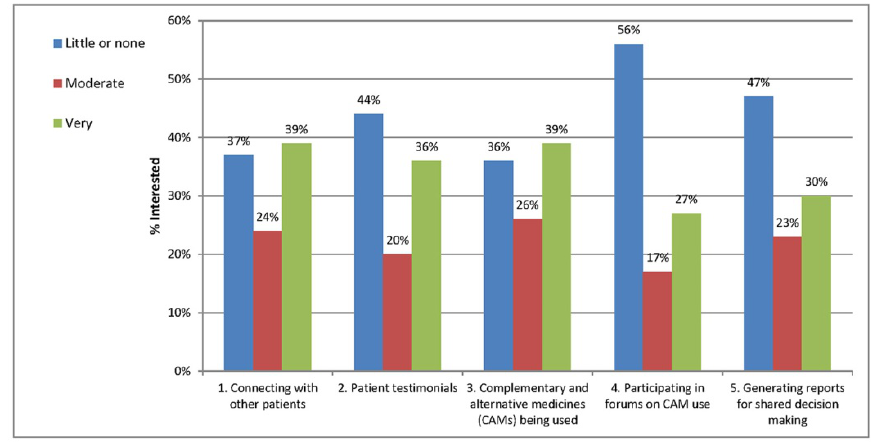
Figure 1 Interest in online portal